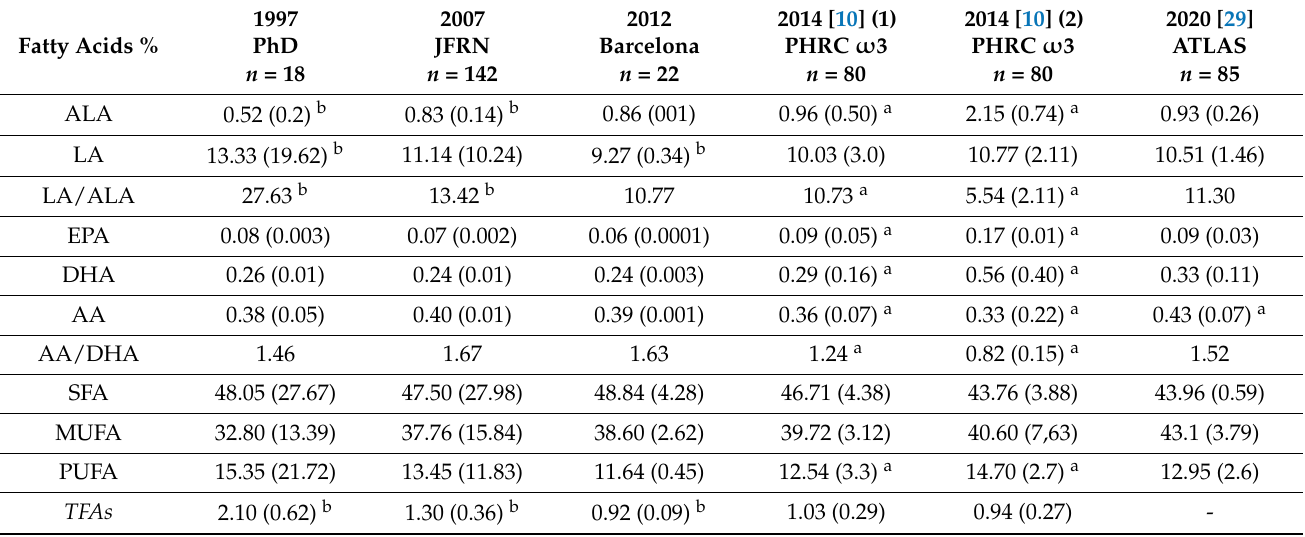
Table 6. Fatty acids evolution in mature human milk from 1997 to 2020 in FRANCE